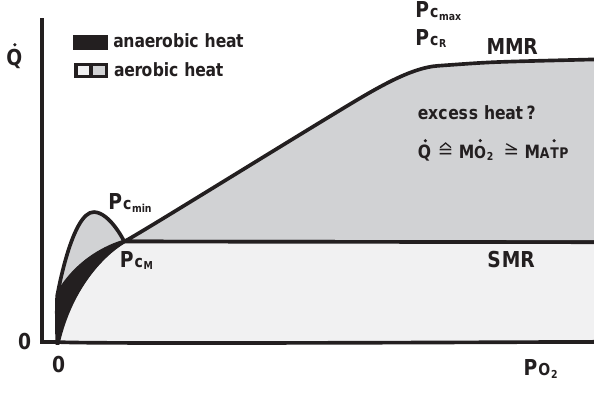
Fig. 1. Graphical presentation of a model used for the comparison of the physiological responses (given as combined ventilatory and cardiac output – Q ) of oxyconforming and oxyregulating animals in declining oxygen tensions (modified after P¨ortner and Grieshaber, 1993). For the sake of clarity, oxygen consumption rates and crit- ical oxygen values are compared in absolute terms, neglecting the fact that standard metabolic rates are variable between species and individuals. Pc M is the Pc below which anaerobiosis starts, Pc R is the Pc of constant aerobic metabolic rate. SMR is the standard metabolic rate, the minimum metabolic rate in complete aerobio- sis (at Pc M ), excluding locomotory activity. An increase in oxy- gen consumption may occur in oxyregulators below Pc M (see text). An aerobic oxyregulator is able to maintain SMR at oxygen par- tial pressure values above Pc M , Pc M equals Pc R . However, it is able to reach maximum metabolic rate during phases of maximum aerobic exercise. Maximum aerobic metabolic rate is reached by full exploitation of energy turnover capacity (high energy consump- tion and associated production). Maintaining this maximum leads to higher levels of Pc (Pc max ) and thus, enhanced hypoxia sensi- tivity as compared to SMR. In contrast, an aerobic oxyconformer regularly exceeds SMR once exposed to high ambient oxygen lev- els and passively exploits its aerobic scope above Pc M , Pc R > Pc M